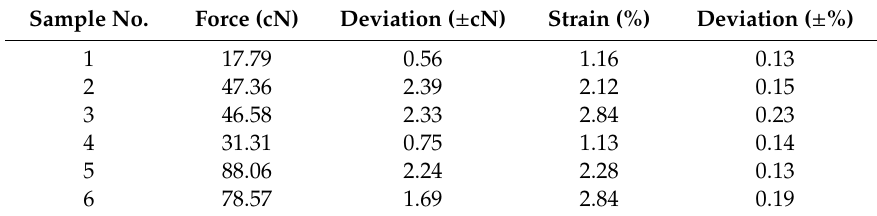
Figure 5. Tensile performance of all the samples. ( a – d ) Force-strain-resistance curves of all the samples from No.1 to No.6 at electrical failure. Table 1. Force and strain of all the samples at electrical failure.